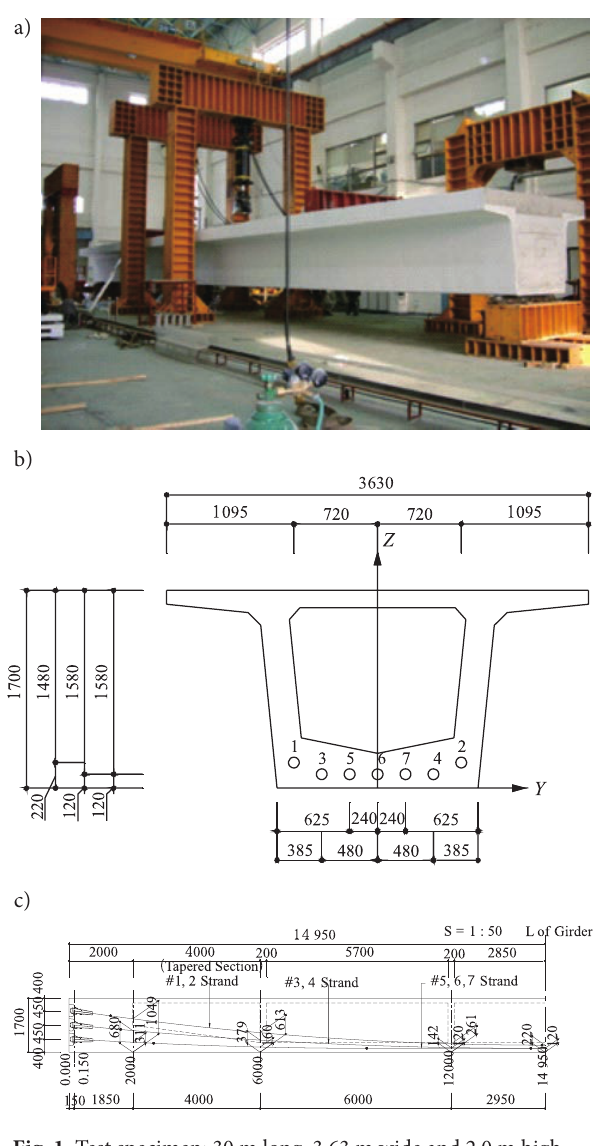
Fig. 1. Test specimen: 30 m long, 3.63 m wide and 2.0 m high small post-tensioned concrete box girder,